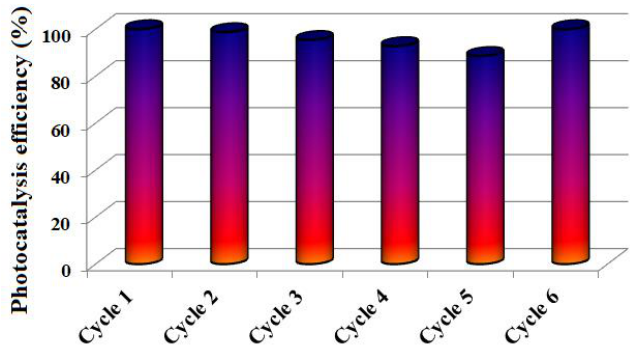
Figure 10. Evolution of the photocatalytic efficiency of M1-Au hybrid film in the degradation of methyl orange after 6 cycles under visible light irradiation (300 min). Cycle 6: after 5 successive cycles, M1-Au film is left 24 h in water and 24 h under normal environmental conditions and after that a new cycle is performed.